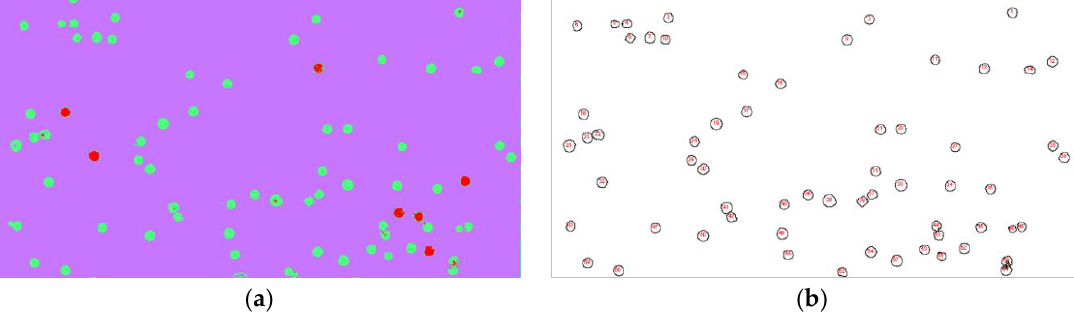
Figure 5. Results of the image process: ( a ) recognition results, and ( b ) counting results of the cell.